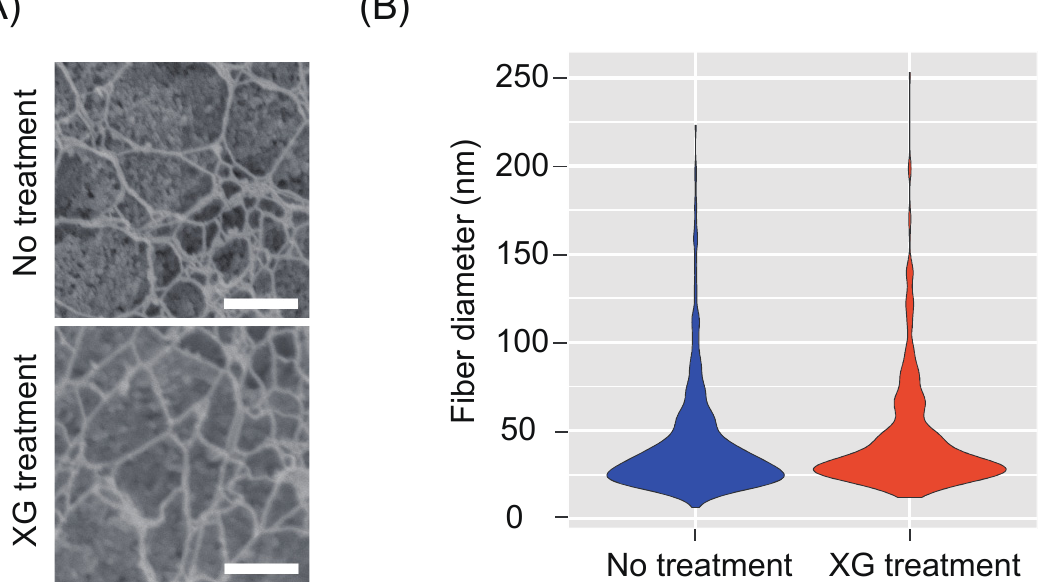
Figure 5. High-resolution imaging analysis of cellulose network, and measurement of fiber diameter in xxt1 xxt2 protoplasts. ( A ) Field-emission scanning electron microscope (FE-SEM) images of the surface of xxt1 xxt2 protoplasts incubated in regeneration medium lacking xyloglucan (top) or containing xyloglucan (bottom) for 12 h. ( B ) Violin plot of fiber diameter calculated from the FE-SEM images ( n = 500 from 50 images). Significance (vs. No treatment) was determined by Student’s t -test ( p < 0.05). Scale bar = 500 nm.